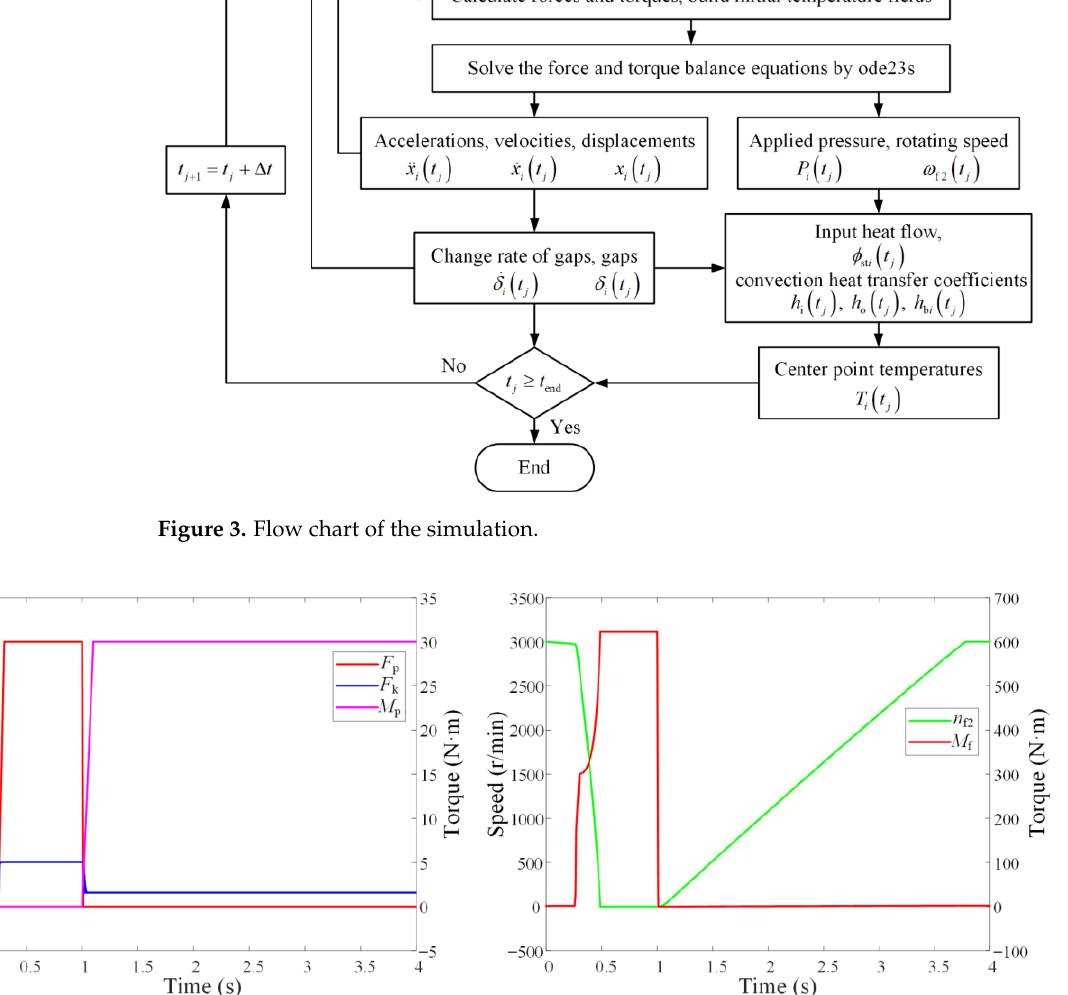
Figure 3. Flow chart of the simulation.